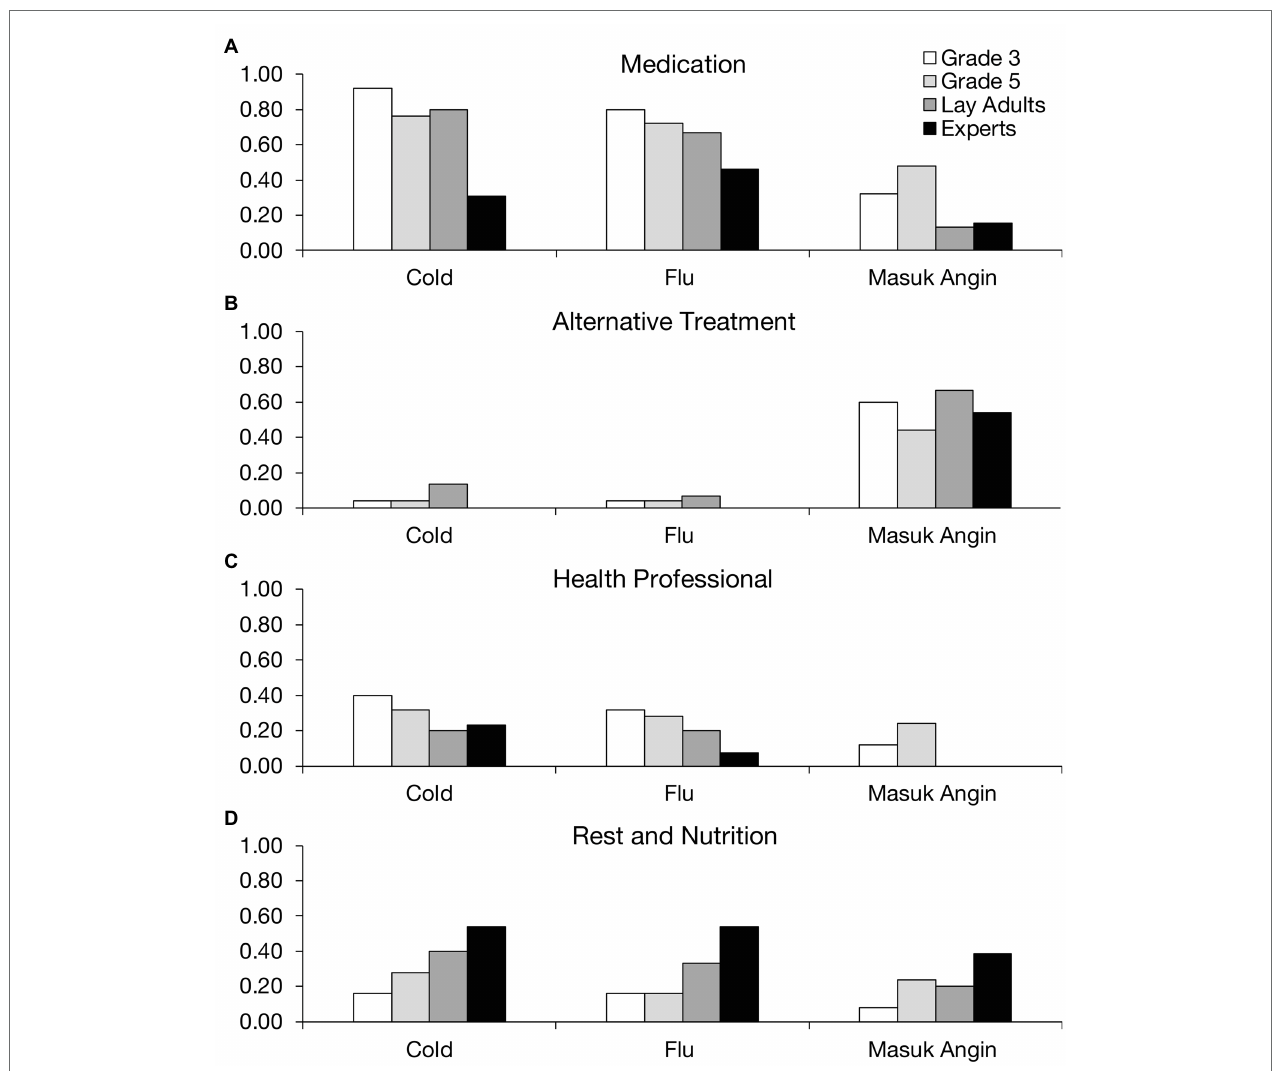
FIGURE 3 | Proportion of participants who mentioned a given treatment for each